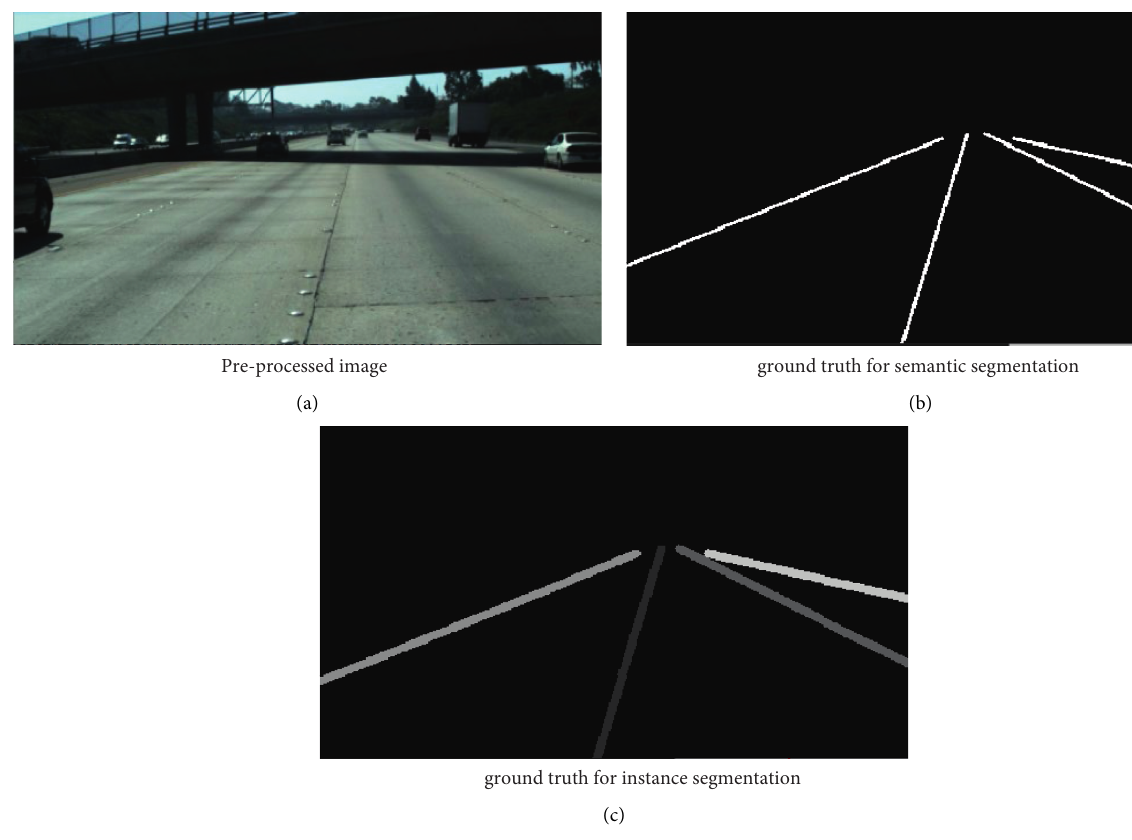
Figure 2: Ground truth. (a) Preprocessed image. (b) Ground truth for semantic segmentation. (c) Ground truth for instance segmentation.